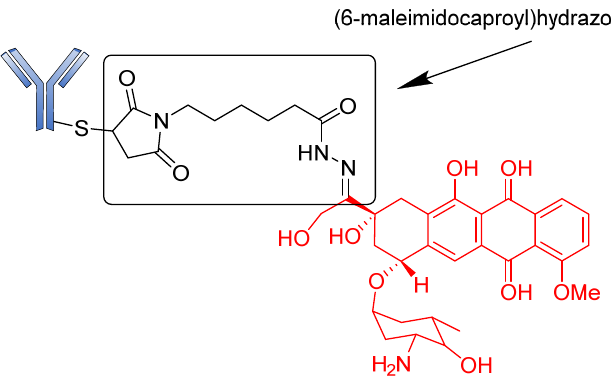
Figure 4. Structure of BR96-doxorubicin.